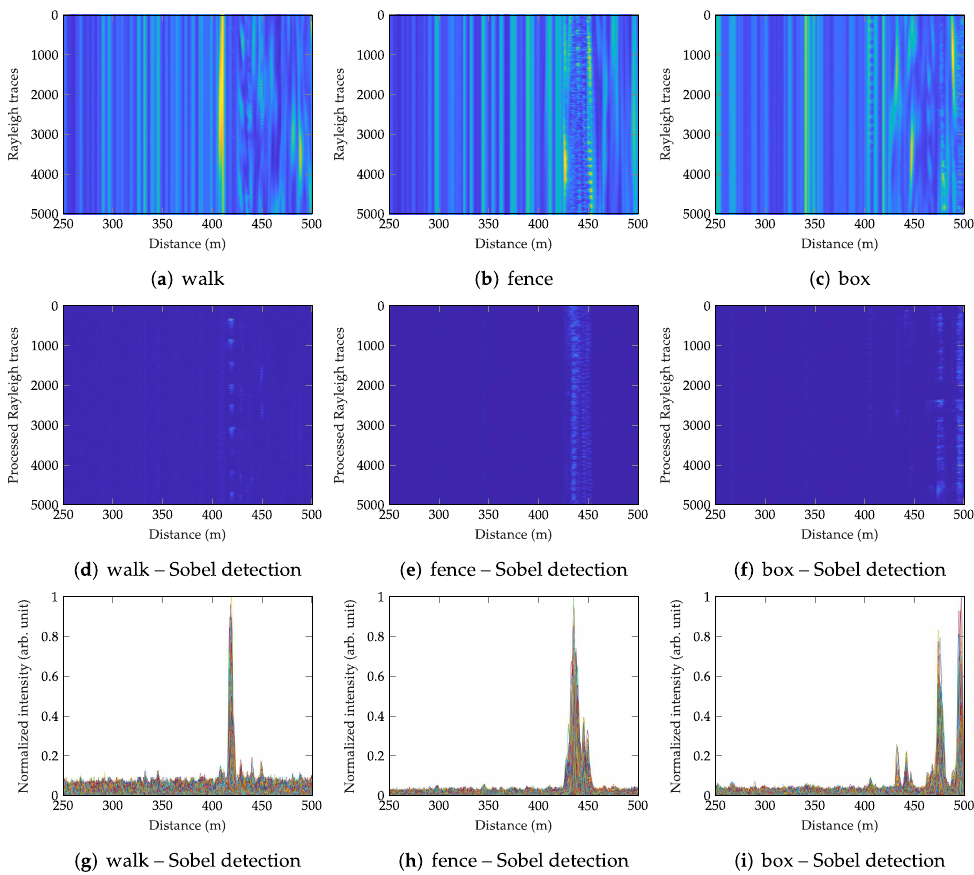
Figure 7. Images of consecutive Rayleigh backscattering traces for the three testing scenarios (walk, fence, box) and the respective images of location information using the Sobel edge detection method with the kernel of size 5 5 ×